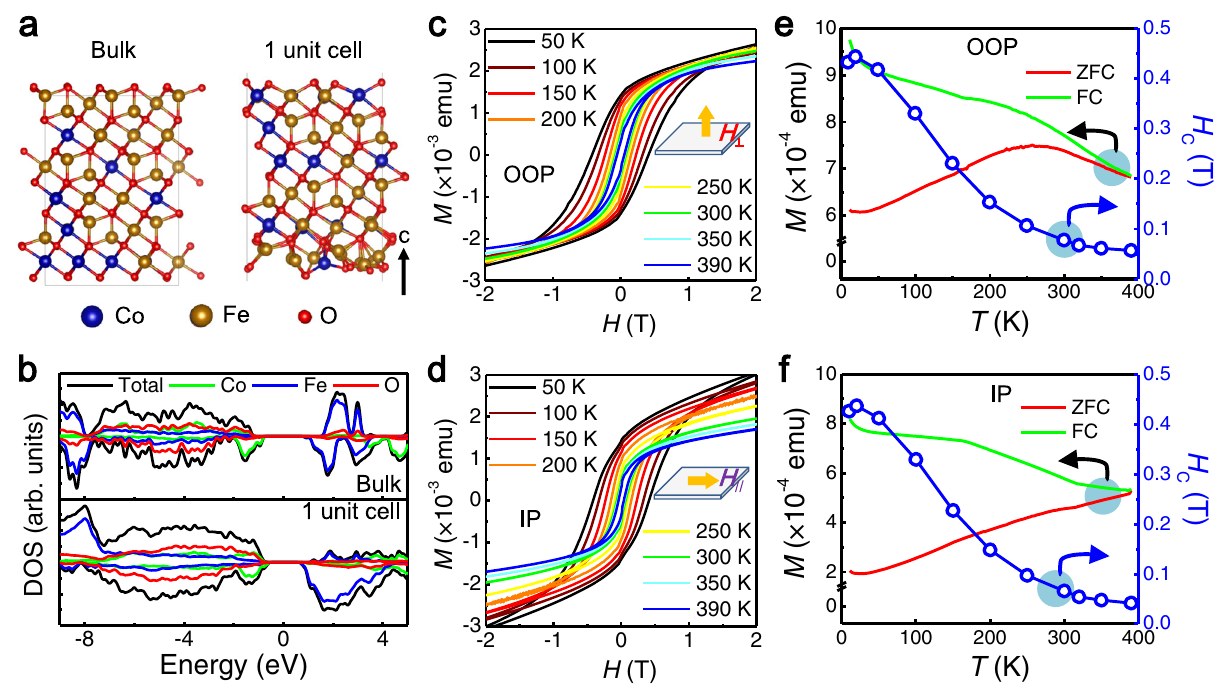
Fig. 3 | Magnetic properties of CFO nanosheet samples. Theoretical models ( a ) andcalculateddensityofstates( b )forbulkCFOand1-unit-cellCFO,respectively. c, d Magnetic hysteresis loops of CFO nanosheet samples measured at different temperatures under out-of-plane (OOP) and in-plane (IP) magnetic fi eld,